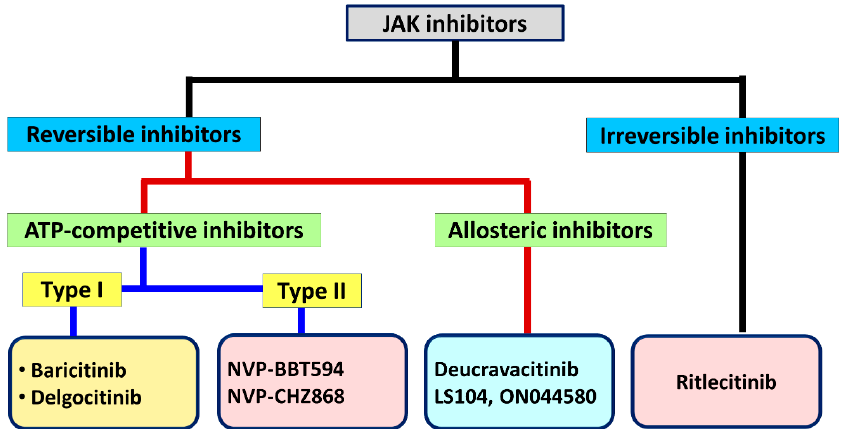
Figure 3. Classification of JAK inhibitors with representative examples for each